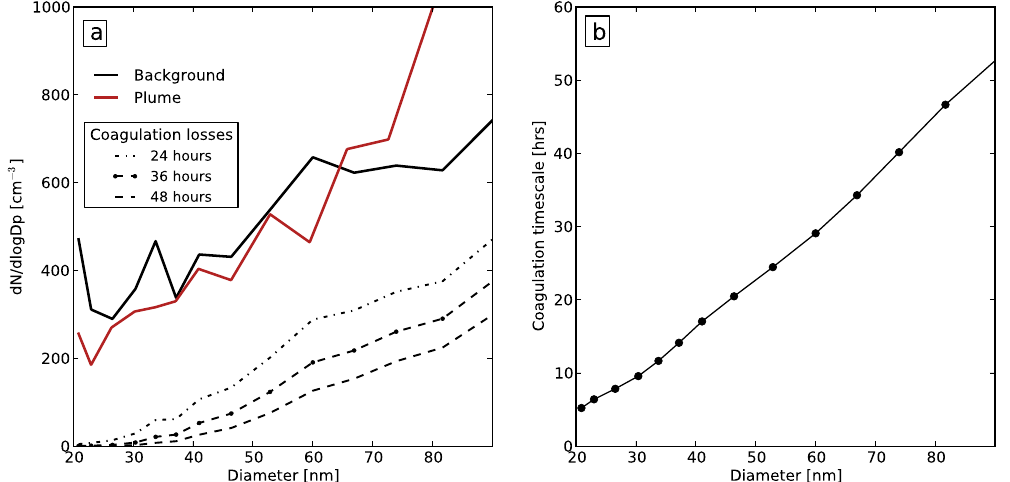
Figure 6. (a) shows background (black solid line) and plume (red line) median concentrations for small-particle diameters (20–90nm). The black dashed lines are the number distributions after 24, 36 and 48h of coagulational losses by the plume accumulation mode (Fig. 5a) from the background level concentrations. These calculated concentrations are much lower than those found in-plume. (b) shows the coagulation lifetime as a function of particle diameter (on the order of tens of hours in this diameter